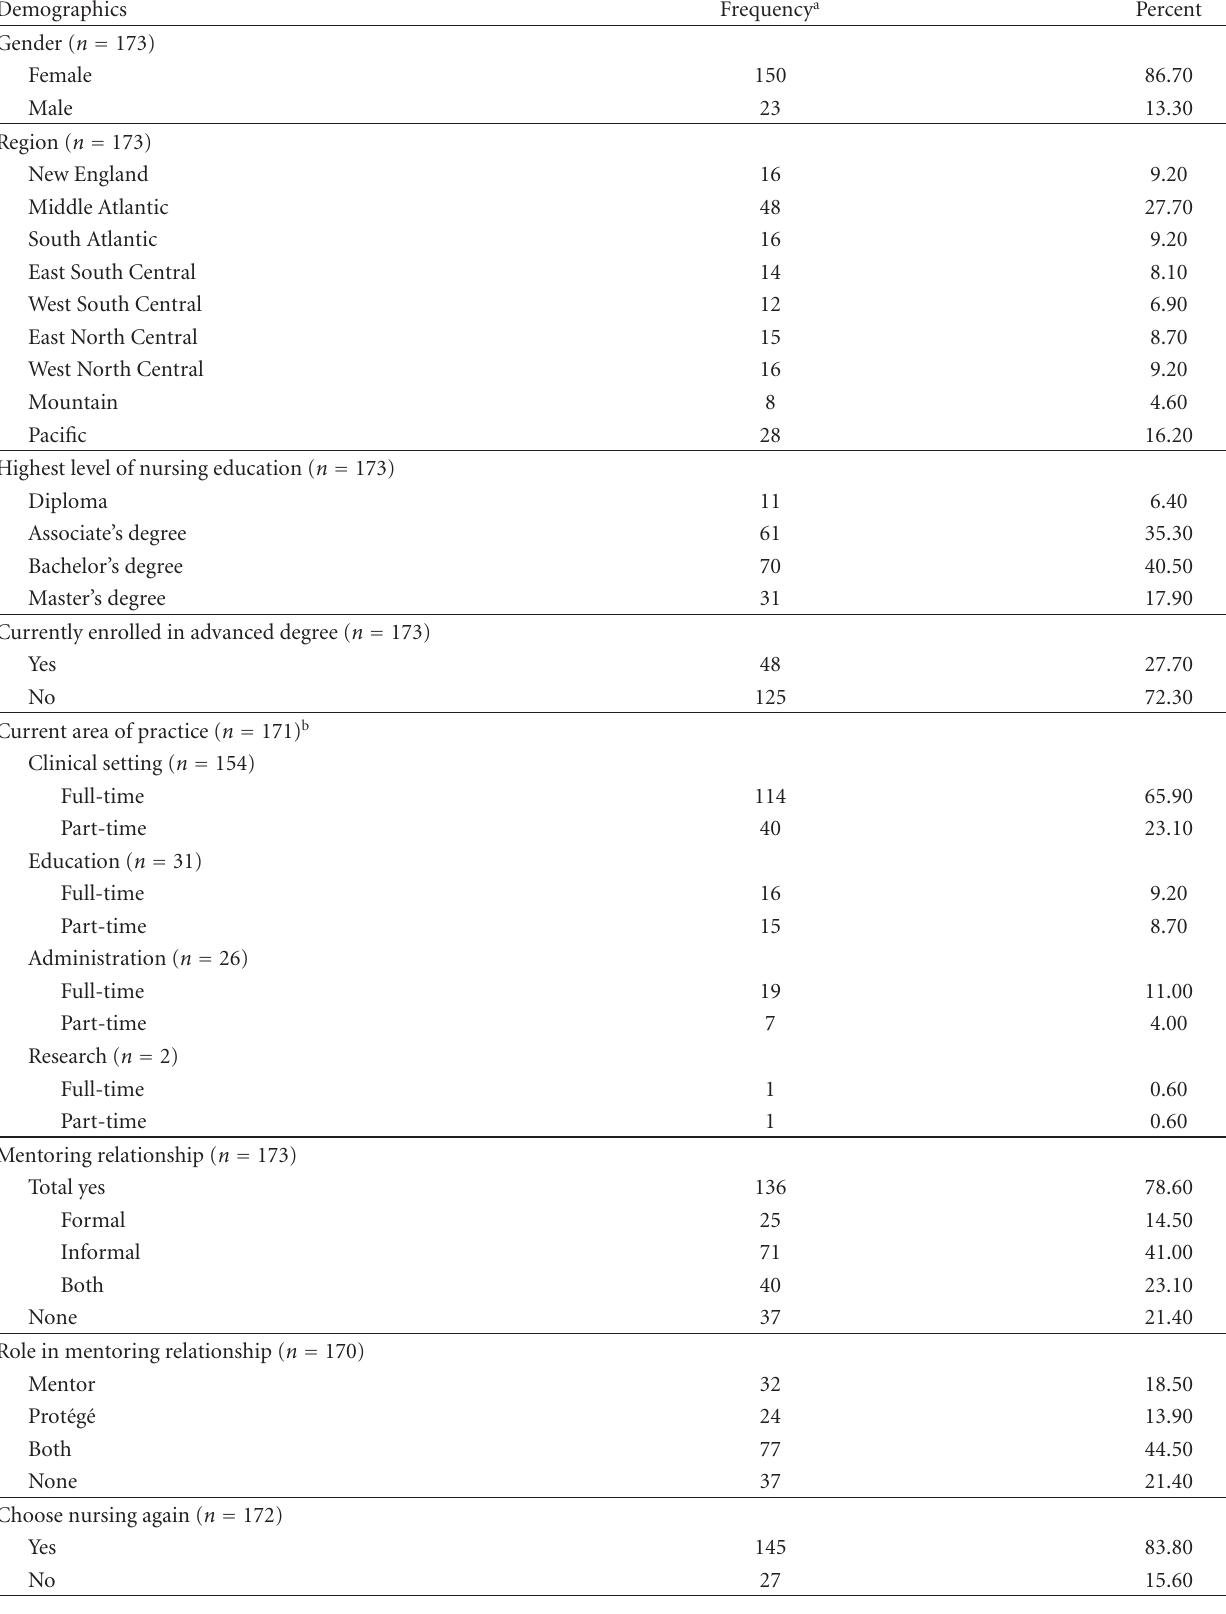
Table 1: Descriptive statistics of categorical demographic data ( N =